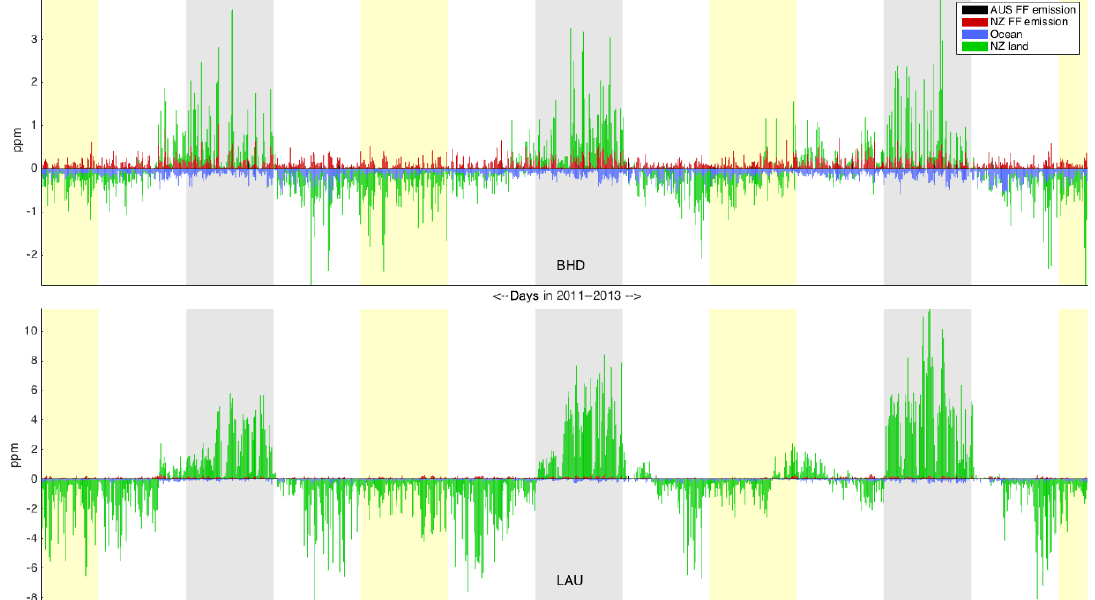
Figure 7. Simulated contributions to the observed CO 2 anomaly, i.e. concentration minus baseline, at BHD (top) and LAU (bottom) for each day in 2011–2013 averaged over both 13:00–14:00 and 15:00–16:00LT release periods. Contributions are calculated using NAME transport matrices with EDGAR v4.2 fossil fuel emissions, prior oceanic CO 2 flux from the Takahashi p CO 2 dataset, and prior terrestrial CO 2 flux from the Biome-BGC model. Note that scales vary due to stronger anomalies and seasonal amplitude at